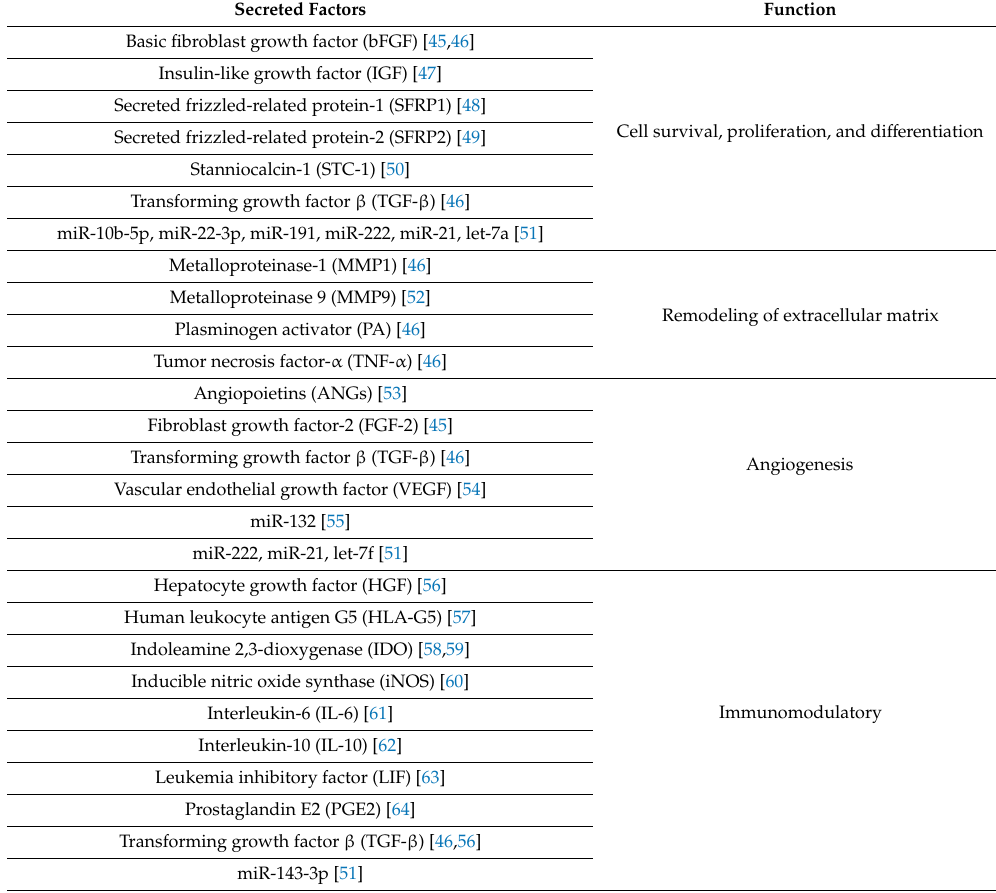
Table 2. Endocrine factors secreted by bone marrow mesenchymal stem